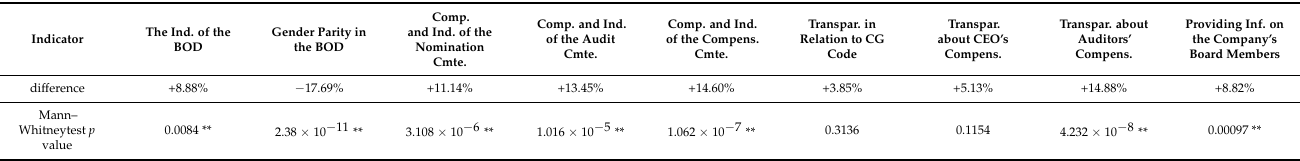
Table 7. Differences in mean values of grades obtained in area of corporate governance by groups of mining, energy, and energy utilities compared to other companies under